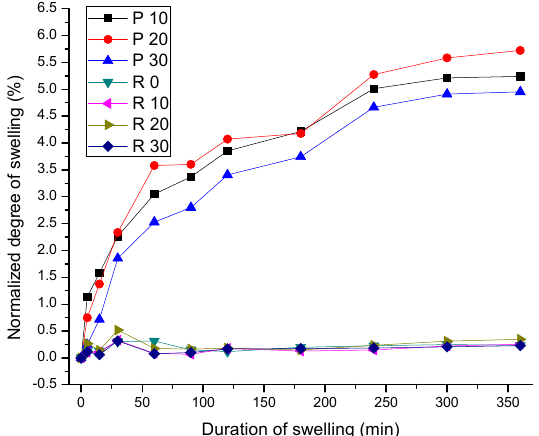
Figure 8. Normalized degree of swelling of the modified photopolymer printing plate samples in methoxypropanol.